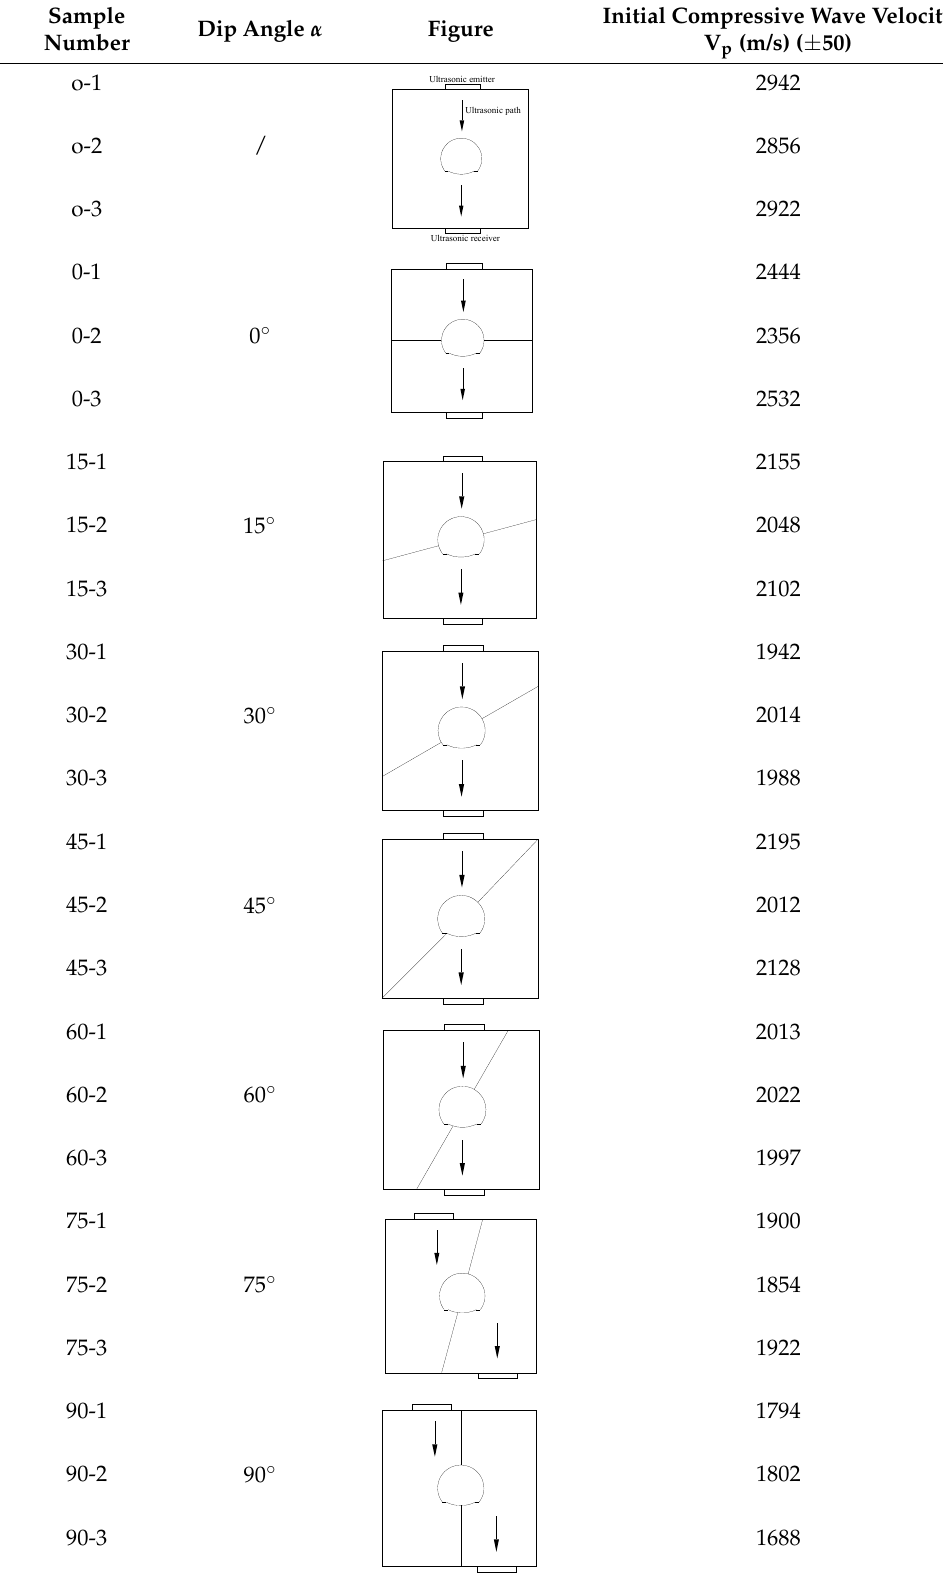
Table 1. Sample Table 1. Sample information. Table 1. Sample information.